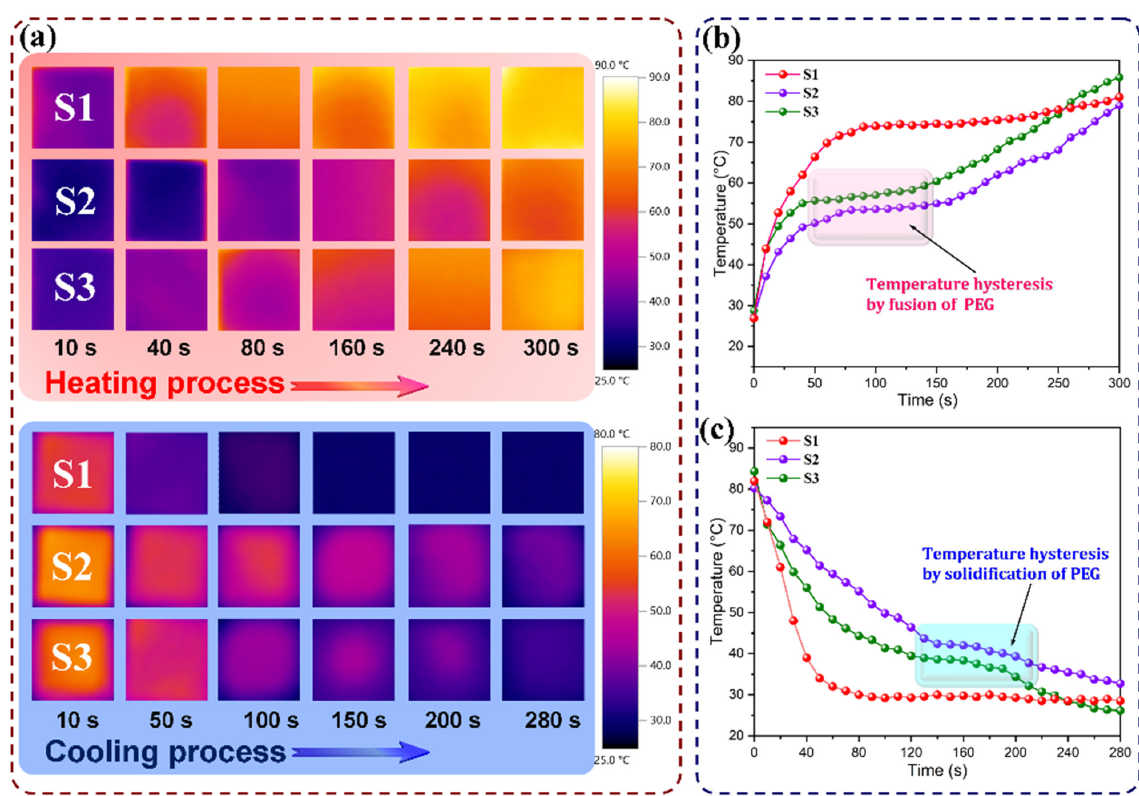
Figure 15. ( a ) IR thermographic images of (S1) PI/graphene/Fe 3 O 4 hybrid aerogel film, (S2) PI aerogel/PEG composite film, and (S3) PI/graphene/Fe 3 O 4 aerogel/PEG composite film recorded during the heating and cooling processes. The plots of temperature evolution as a function of time in ( b ) the heating and ( c ) cooling processes determined from IR thermographic analysis.